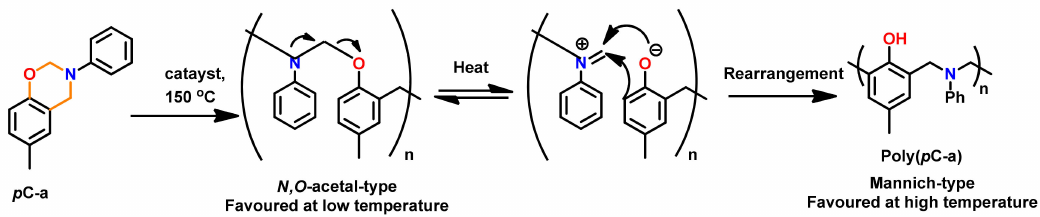
Figure 47. Formation of different linkages in polybenzoxazine framework at different temperatures [269].